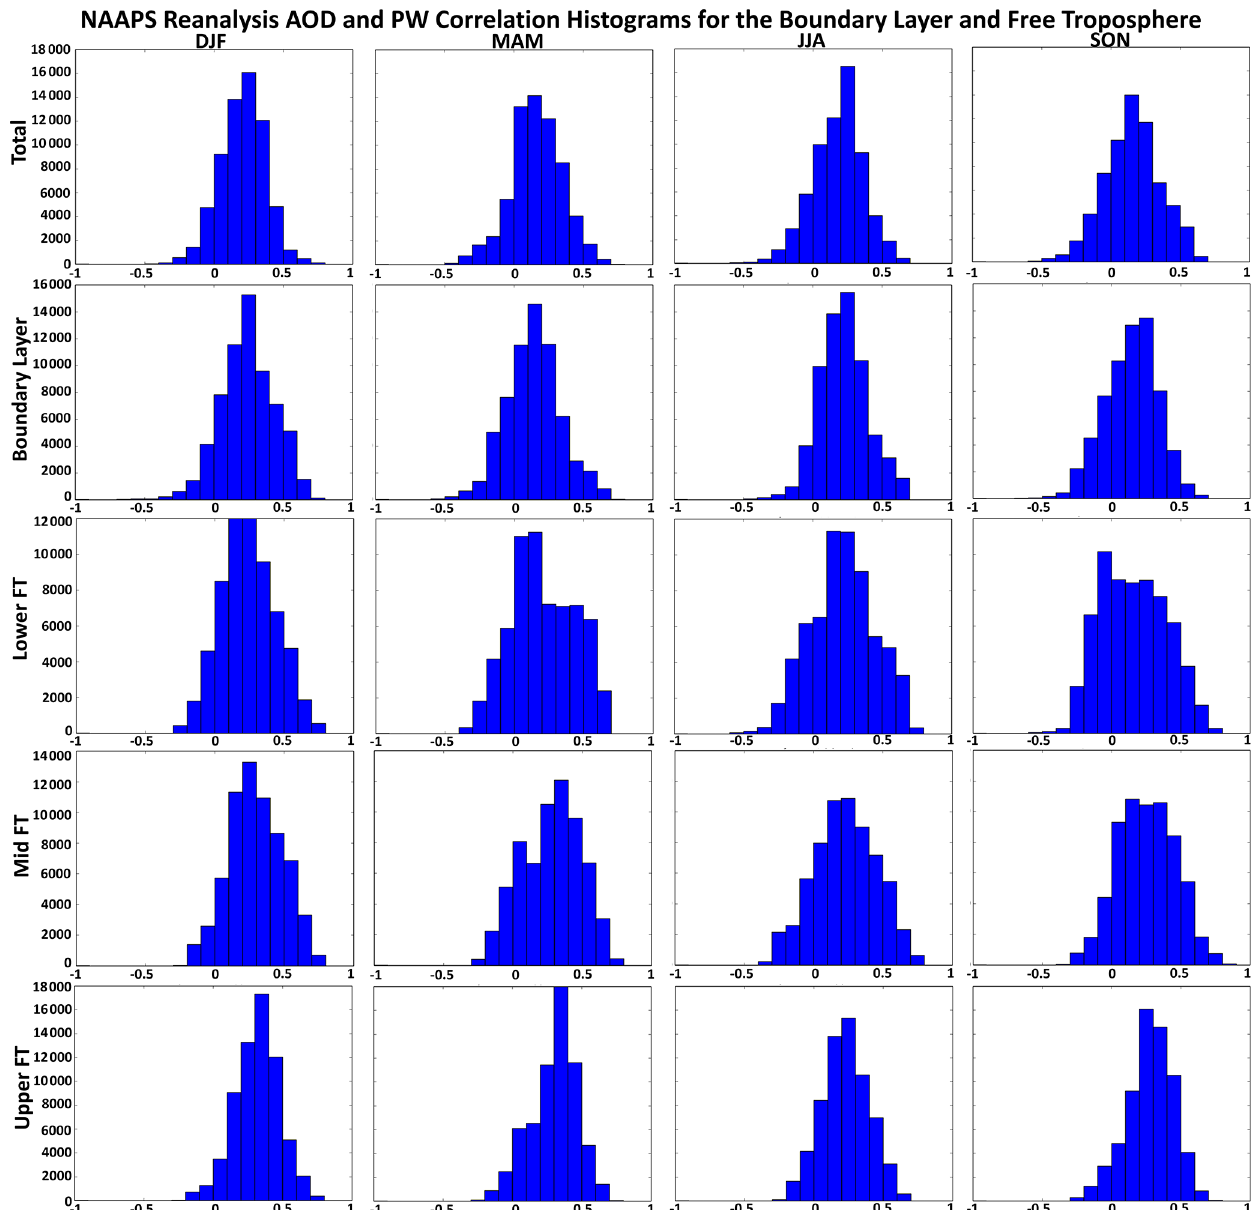
Figure 12. AOD and PW correlation histograms by season for the full integrated column (total) and vertical components of the atmosphere (boundary layer and lower, middle, and upper free troposphere